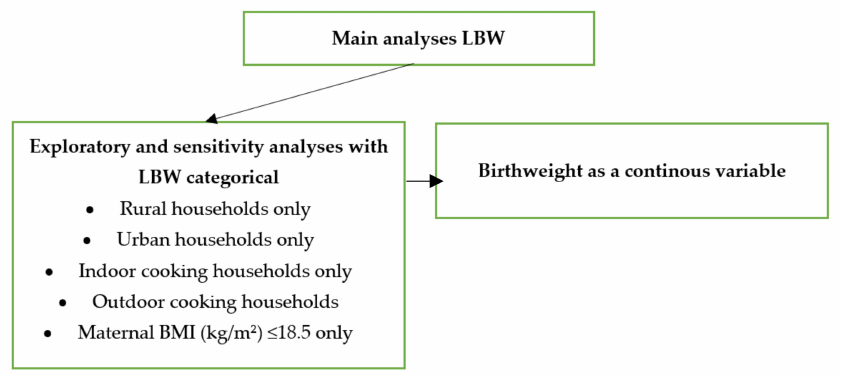
Figure 1. Description of sensitivity